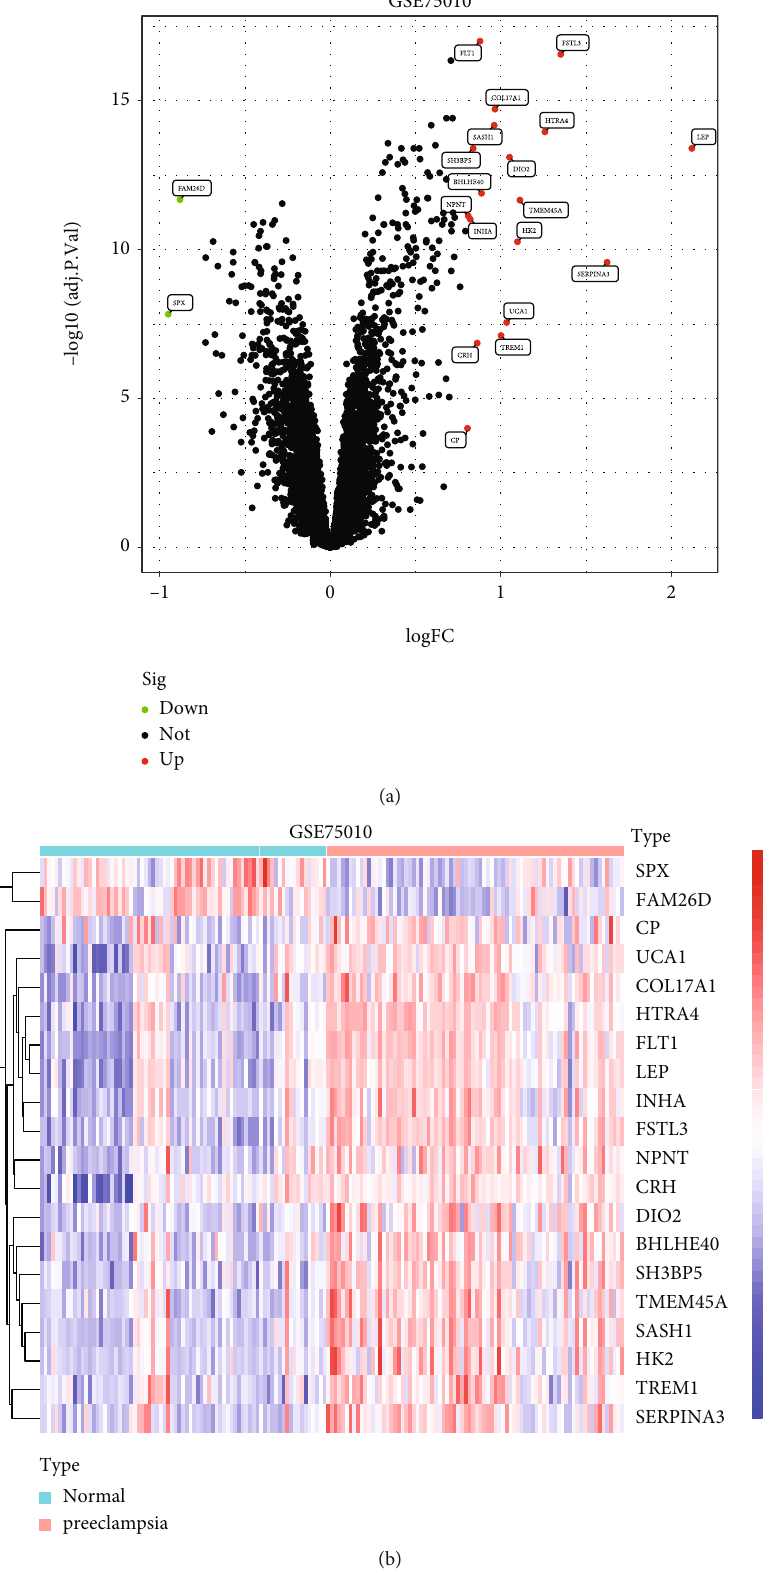
Figure 1: The dysregulated genes were shown in the (a) volcanic map and (b) heat map via analyzing GSE75010 datasets. 20 DEGs were identi fi ed between preeclampsia samples and normal